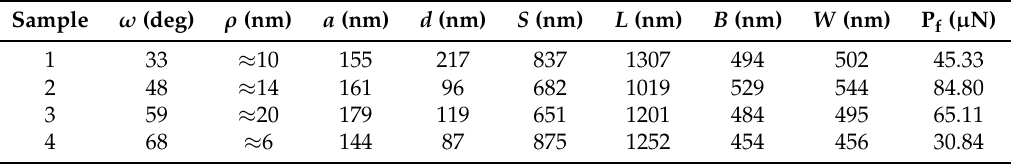
Figure 2. Example of main steps of fabrication process, orientation, final sample (specimen 2) and geometrical details of the blunt V-notched nano-cantilevers. At first, a block is carved from bulk single crystal silicon plate; later, the block is positioned on a gold wire and the nano-cantilever is cut; the notch is finally introduced by focused ion beam (FIB). Table 2. Geometrical parameters of the blunt V-notched nano-cantilevers (see Figure